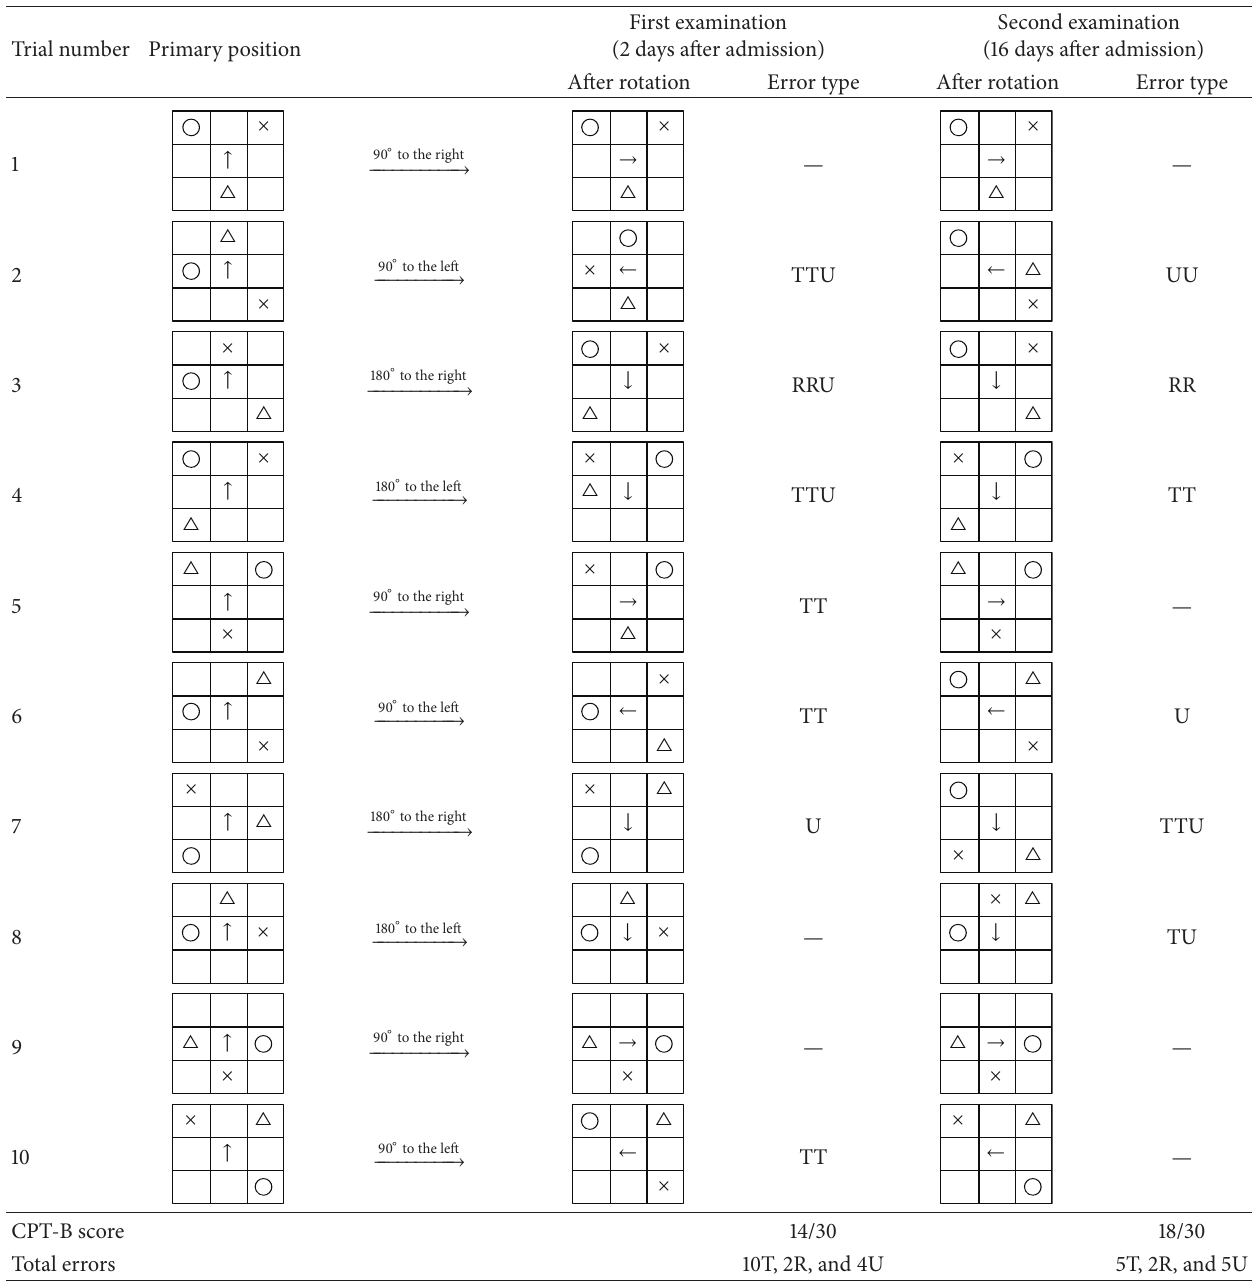
Table 2: Results of CPT-B on the present